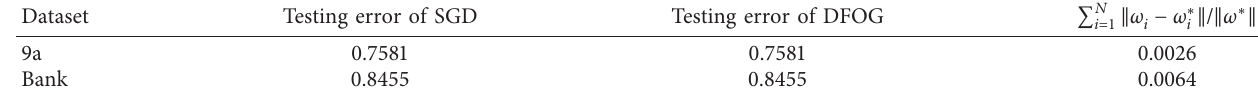
Table 2: Testing error and the relative error of